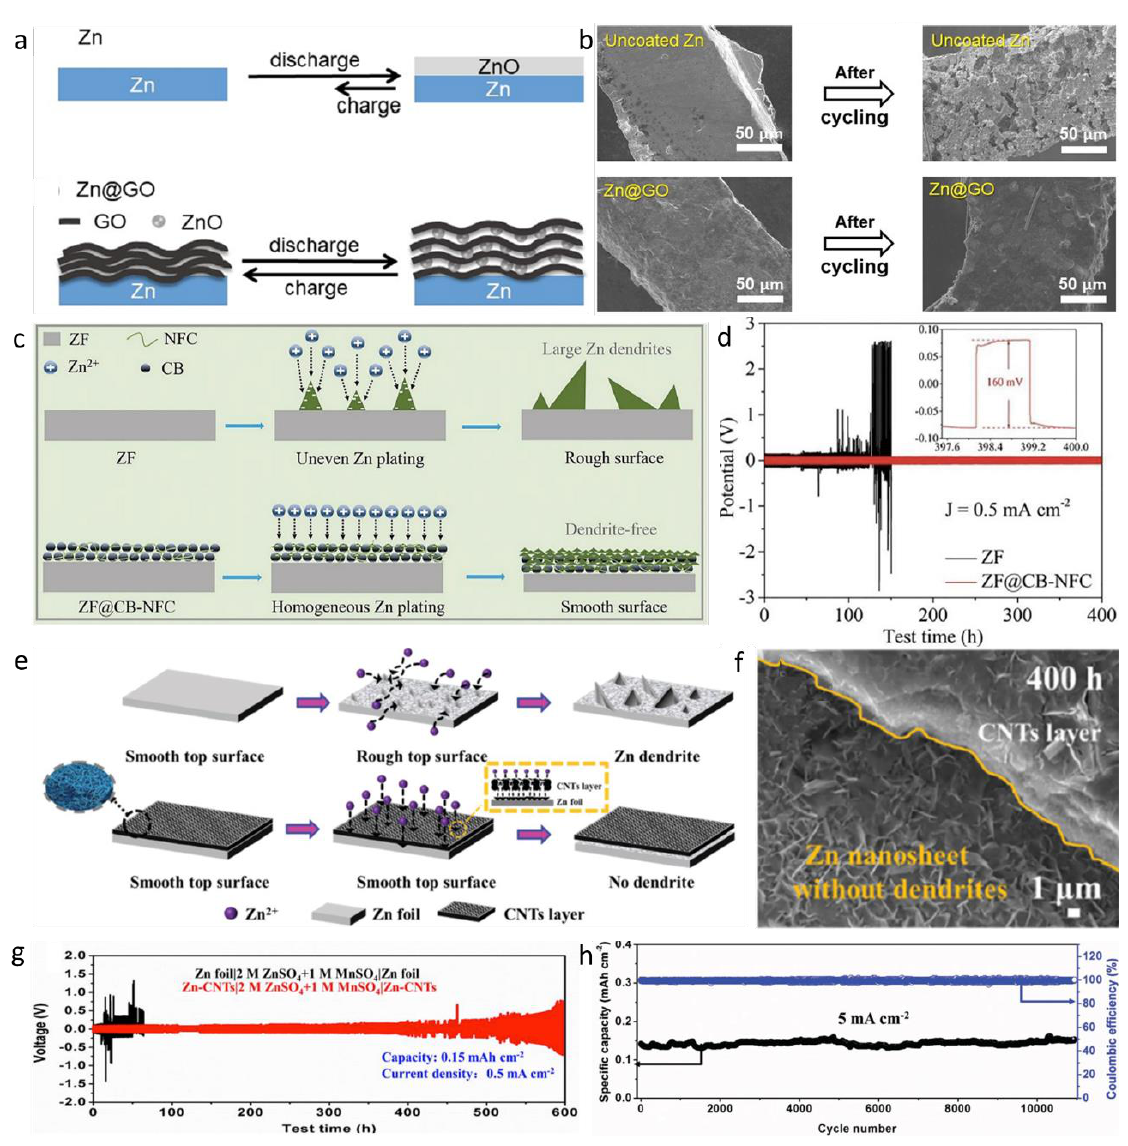
Figure 4. ( a ) Diagram of morphological changes occurring on zinc electrodes during electrochemical cycling and ( b ) SEM images of bare Zn anode before and after cycling and SEM images of bare Zn@GO anode before and after cycling (Reproduced with permission [69] Copyright 2019, Elsevier). ( c ) Schematic illustrations for the evolution of surface morphology of the pure ZF and ZF@CB during Zn plating and ( d ) Cycling performance of ZF@CB|ZF@CB symmetrical cells at the current density of 0.5 mA cm − 2 (Reproduced with permission [70] Copyright 2020, Elsevier). ( e ) Schematic illustra- tions for morphology evolution of bare Zn anode and anti-dendrite mechanism of Zn-CNTs anode, ( f ) SEM image of Zn-CNTs surface after 400 h. ( g ) Typical galvanostatic discharge-charge profiles of symmetric cells with bare Zn foil and Zn-CNTs anode at a current density of 0.5 mA cm − 2 , and ( h ) cycling performance at 5 mA cm − 2 and Coulombic efficiency as a function of cycles (Reproduced with permission [71] Copyright 2019, John Wiley &